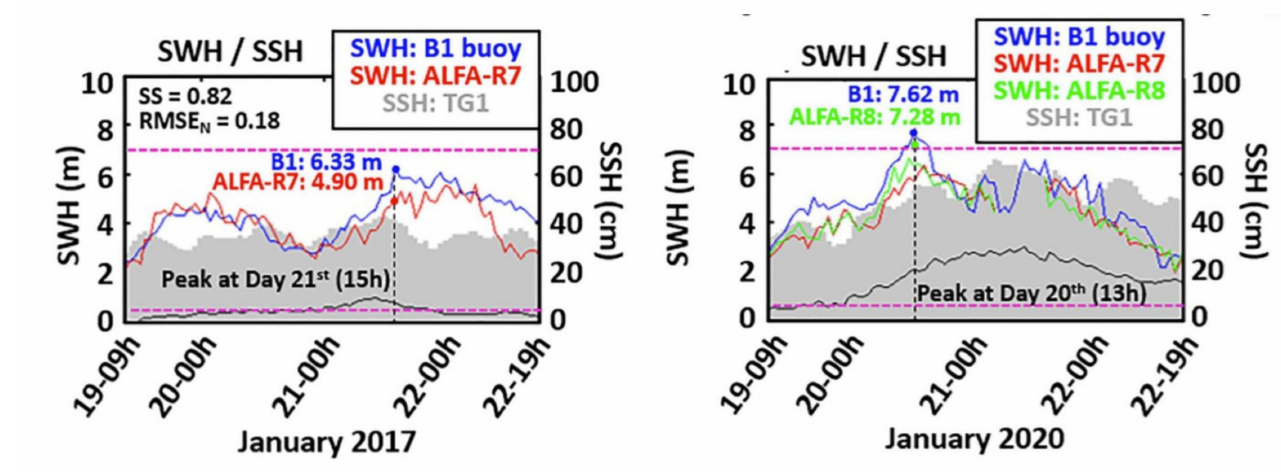
Figure 7. Comparison of measurements collected by different instruments during two storms that occurred in 2017 and 2020 (adapted from [121]). The abbreviations in the plots are explained in the main text of this